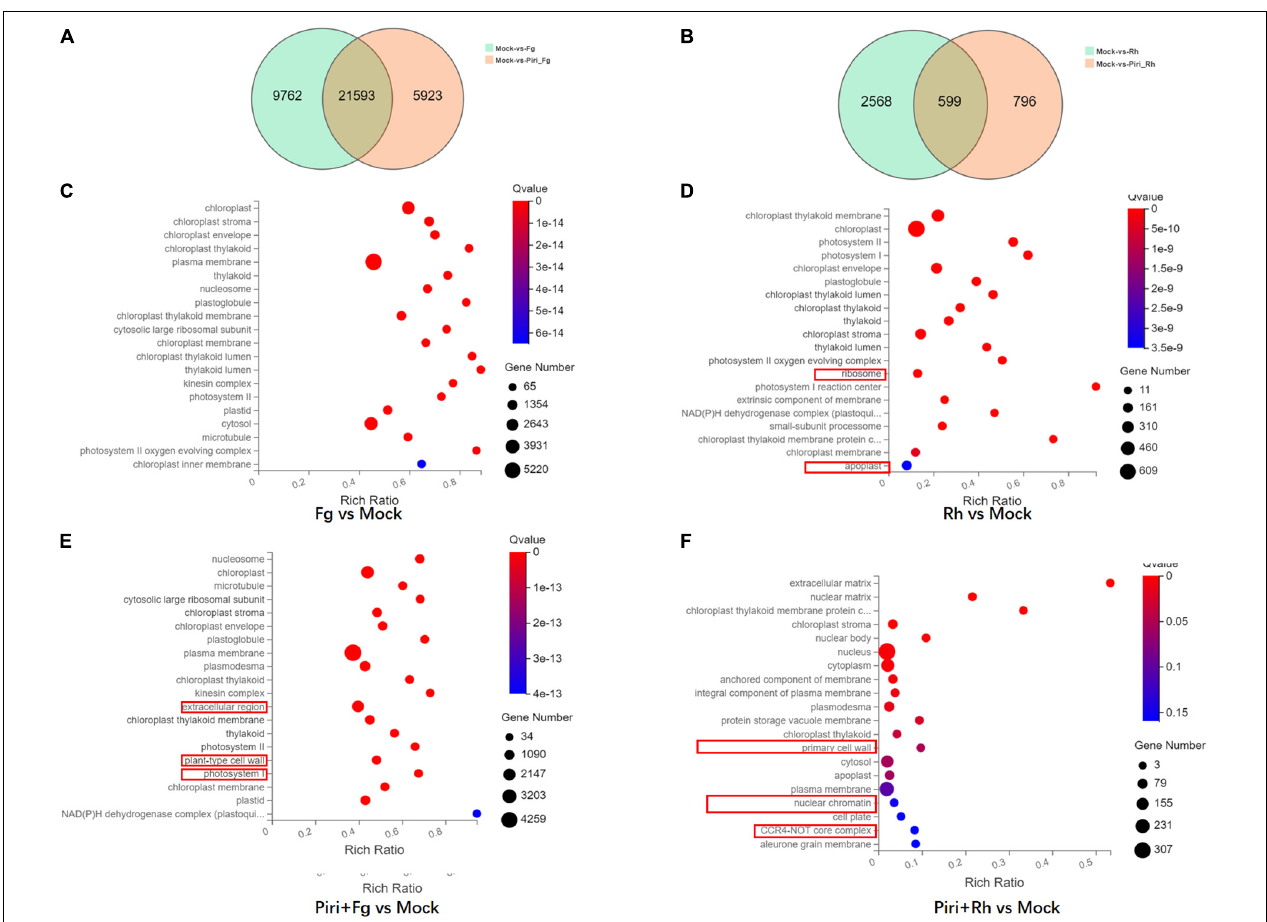
FIGURE 7 | Profile of different expressed genes in wheat responsive to P. indica and pathogens colonization. (A) Venn Diagram of the different expressed genes (DEGs) between Fg vs. Mock and Piri + Fg vs. Mock. (B) Venn Diagram of the DEGs between Rh vs. Mock and Piri + Rh vs. Mock. (C) DEGs enriched in KEEG pathway in Fg vs. Mock group. (D) DEGs enriched in KEEG pathway in Rh vs. Mock group. (E) DEGs enriched in KEEG pathway in Piri + Fg vs. Mock group. (F) DEGs enriched in KEEG pathway in Piri + Rh vs. Mock group (/log2 FC/ > = 1, Q-value < = 0.05). Piri, P. indica ; Fg, F. graminearum ; Rh, R. cerealis ; Piri + Fg, P. indica + F. graminearum ; Piri + Rh, P. indica + R.